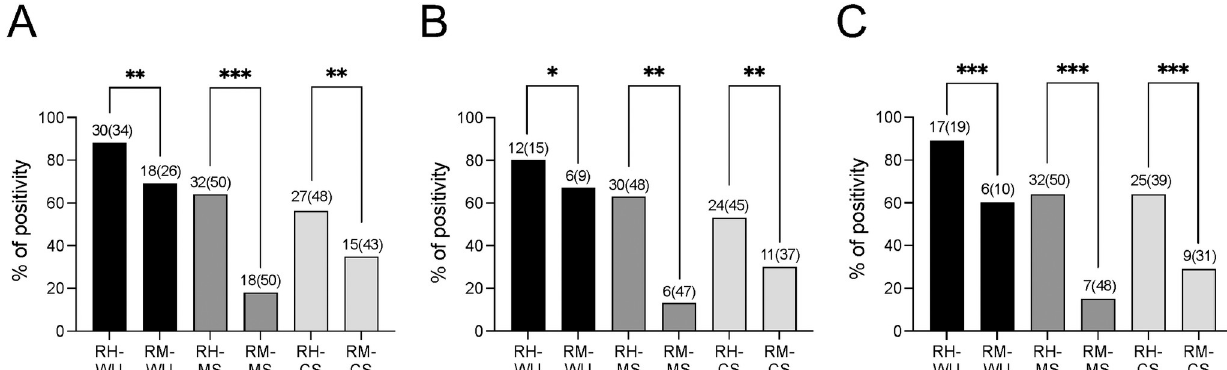
Fig 2. Prevalence of arsB gene among E . coli isolates. Prevalence of E . coli isolates positive for arsB gene in A) total no. of E . coli isolates, B) third- generation cephalosporin-resistant E . coli isolates, and C) fluoroquinolone-resistant E . coli isolates obtained from water (WU), mother stool (MS), and child stool (CS) samples collected from the Hajiganj (RH, high arsenic exposure) and Matlab (RM, low arsenic exposure) areas in Bangladesh. Each bar represents the percentage of E . coli isolates that are positive for the arsB gene. The numbers on top of each bar indicate the number of E . coli isolates that are positive for the arsB gene and the numbers in parenthesis indicate the total number of E . coli isolates for each type of sample. The asterisks indicate significance ( � p < 0.05, �� p < 0.01, ��� p < 0.001).